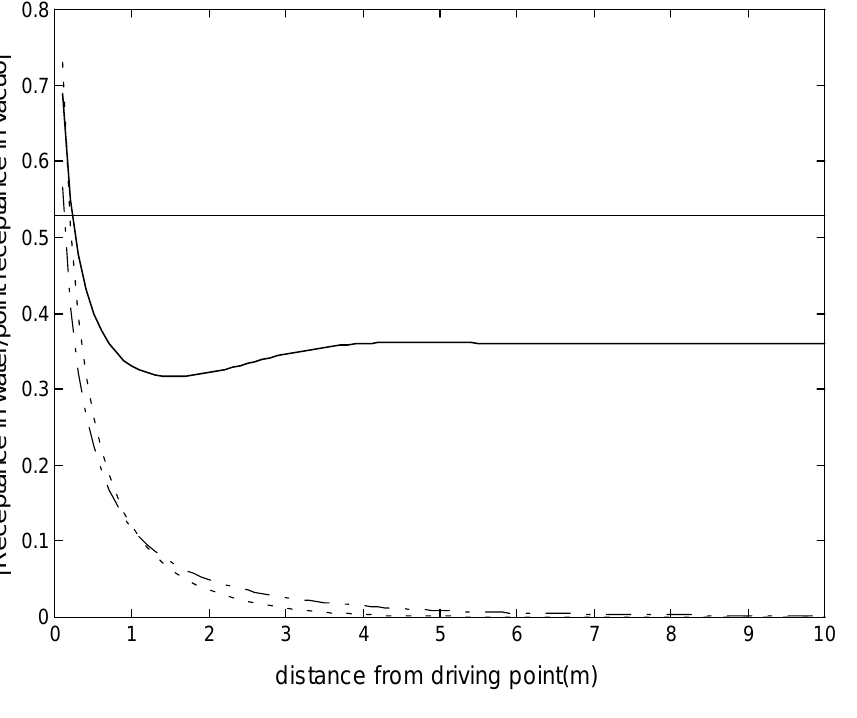
Fig. 12. The comparison of receptance in water and in vacuo. the free wave contribution; − − -, the evanescent wave contribution; − - − , the acoustic contribution; —, the point drive receptance. The frequency is 10 Hz and plate thickness is 0.04 m. p = sound pressure in the fluid { F } = excitation force and moment { x } = displacement vector at centre gravity of rigid